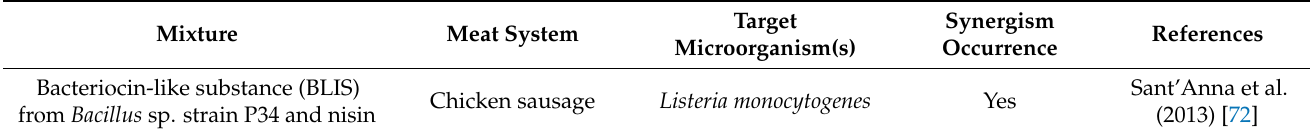
Table 4. The use of a combination of bacteriocin with BLIS against a target microorganism.